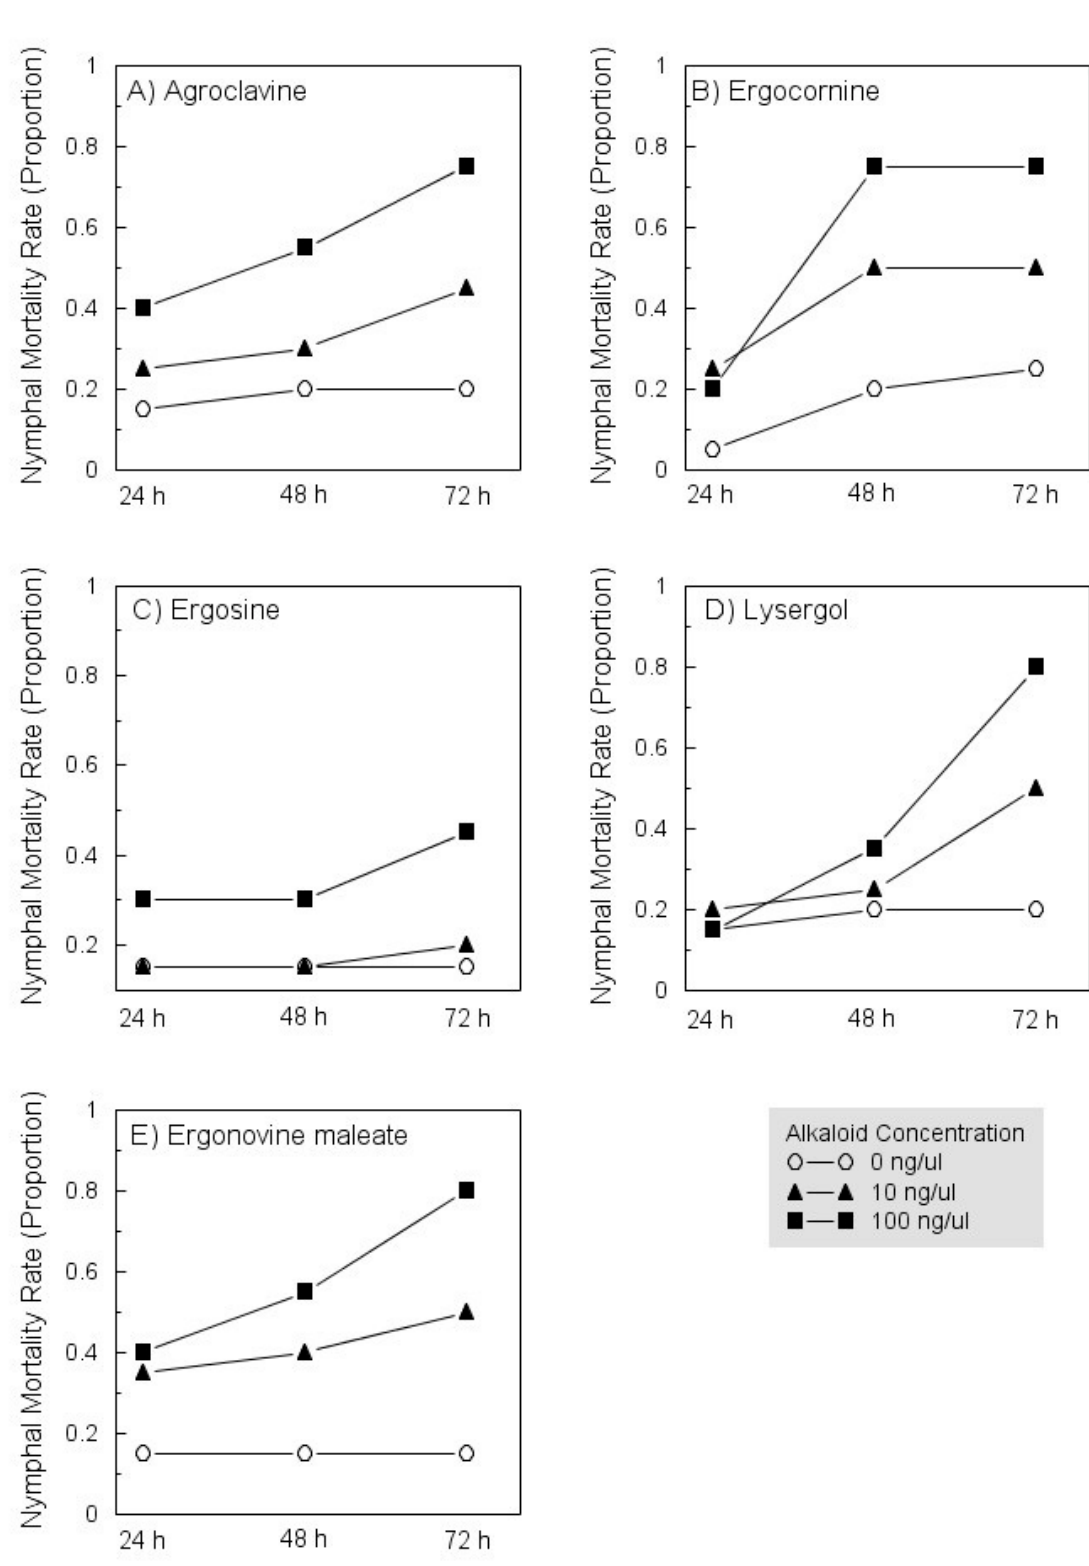
Figure 1. Exposure-dependent mortality rates among Diaphornia citri nymphs exposed to leaves treated with increasing concentrations of agroclavine ( A ), ergocornine ( B ), ergosine ( C ), lysergol ( D ), or ergonovine maleate ( E ). See Table 3 for statistical results. The figure depicts morality observed with the control (0 ng/µL) and at the two highest concentrations tested, 10 and 100 ng/µL.